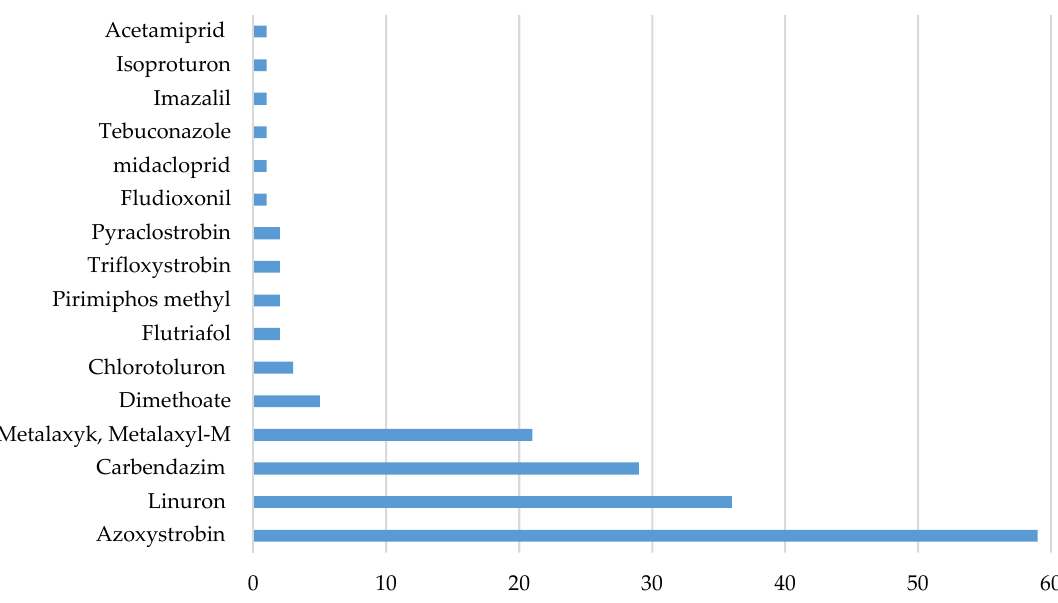
Figure 2. Pesticide occurrence frequency in analysed samples.